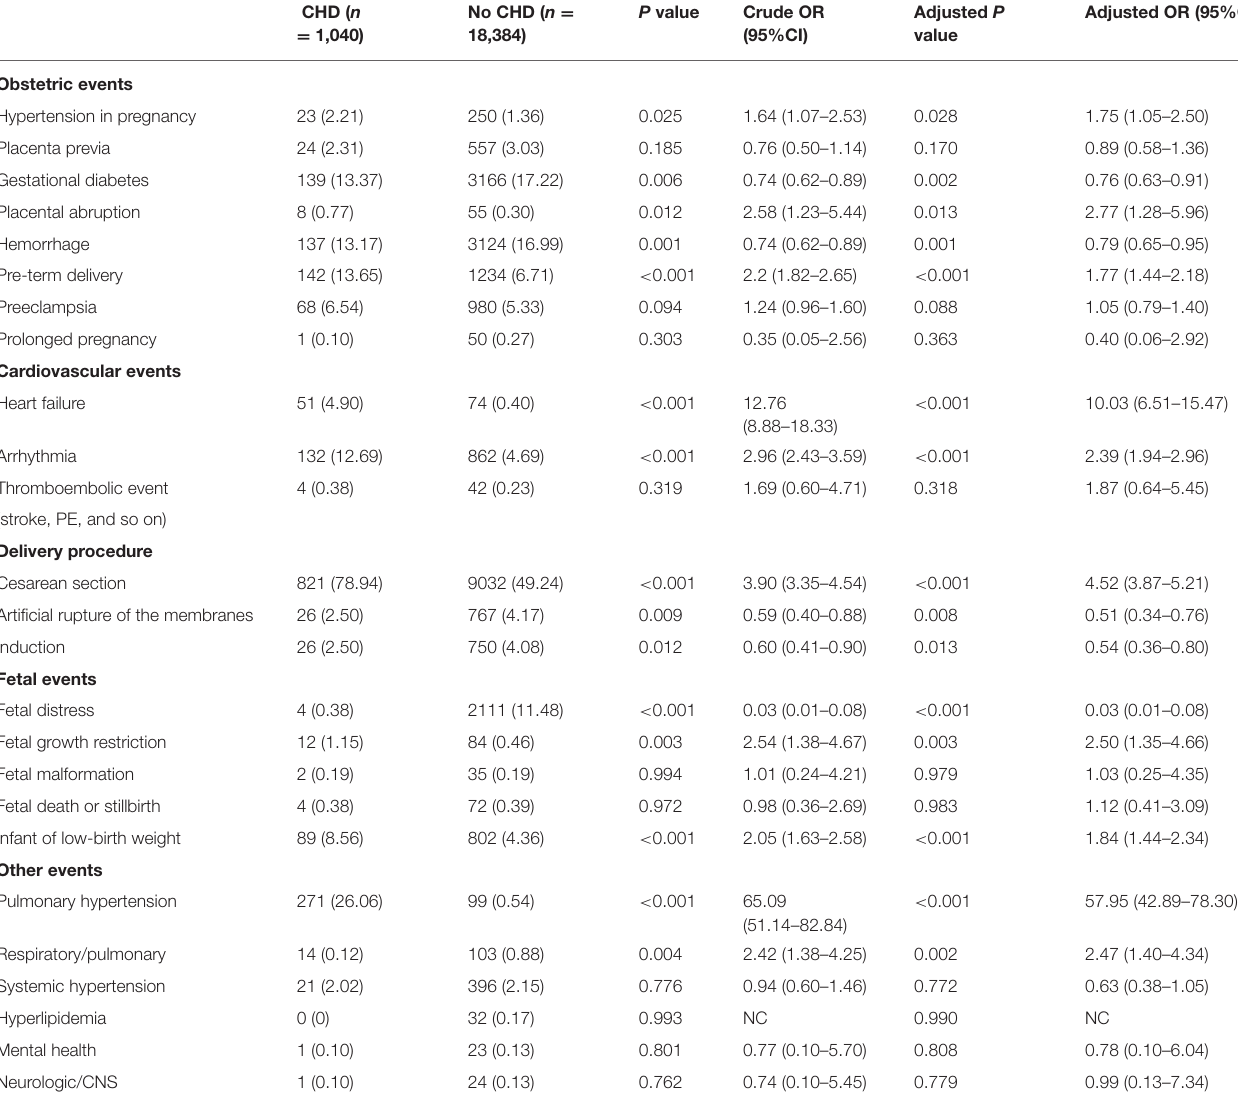
TABLE 2 | Adverse cardiovascular, obstetric, and fetal events experienced by women with and without CHD admitted for delivery.